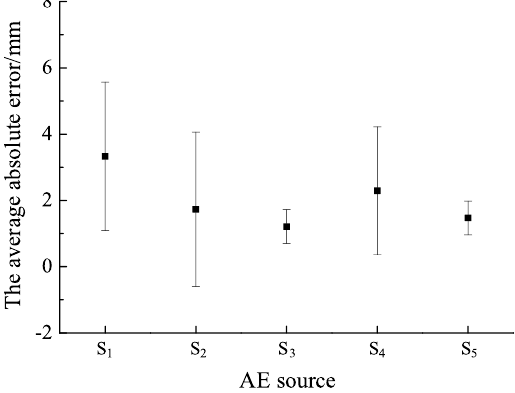
Figure 8. The average absolute errors of the AE source in the 2D location test.